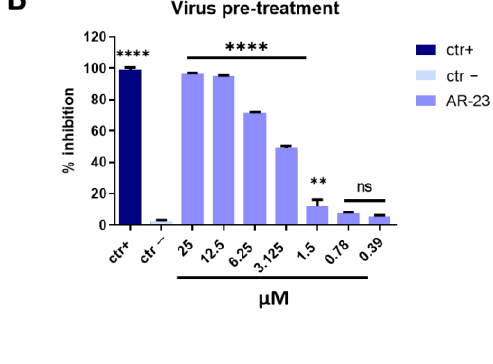
Figure 4. Antiviral activity against MeV. Different assays were performed in order to evaluate an- ti-MeV activity. ( A ) Co-treatment: simultaneous addition of AR-23 and virus to the cells; ( B ) Virus pre-treatment: virus incubated with the peptide, and then used to infect cells; ( C ) Cell pre-treatment: AR-23 incubated with the cells before the viral infection; ( D ) Post-treatment: AR-23 added to the infected cells. Peptide AR-23 inhibited the early stages of infection, acting in co-treatment ( A ) and virus pre-treatment ( B ) assays, while it was not able to interact with the cel- lular surface ( C ) or block the viral replication ( D ). Different compounds were used as positive control (ctr+) for each treatment: mucroporin M1 ( A , B , 10 μ M for both the assays) [40] , FIP peptide (C, 20 μ M) [41] , and 5′ -nor carbocyclic adenosine analogue (D, 5 μ M) [42] , while infected cells were used as negative control (ctr-). **** p < 0.0001; *** p < 0.0002; ** p < 0.0021; * p < 0.021; ns: non-significant. Figure 5. Antiviral activity against HPIV-2. Different assays were performed in order to evaluate anti-HPIV-2 activity. ( A ) Co-treatment: simultaneous addition of AR-23 and virus to the cells; ( B )